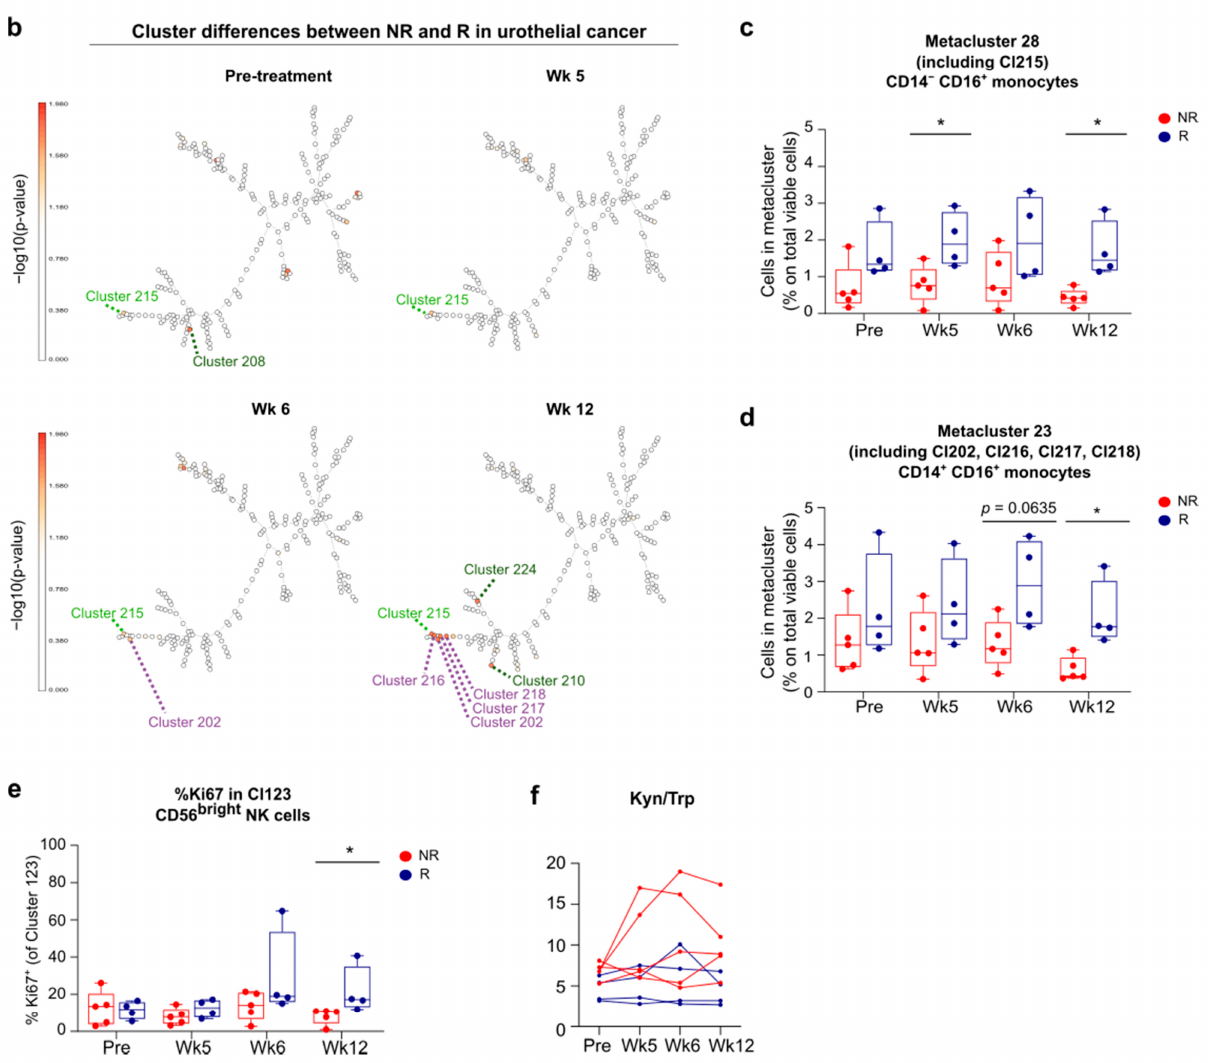
Figure 6. Increased frequency of monocytes associates to response in urothelial cancer. ( a ) FlowSOM tree of concatenated flow cytometry data of PBMCs from 9 UC patients (arm B, 36 samples). ( b ) UC FlowSOM trees depicting differences in the percentage of cells assigned to clusters between non-responders and responders at pre-treatment, week 5, week 6 and week 12 of anti-PD-1 treatment. − log10( p values) are plotted on trees showing the significantly over- or underrepresented clusters in non-responders versus responders. Colors of cluster numbers correspond with immune cell populations in a. ( c ) Boxplots with percentages of metacluster 28 corresponding to CD14 − CD16 + monocytes in non-responders (NR) and responders (R) at indicated times. ( d ) Boxplots with percentages of metacluster 23 corresponding to CD14 + CD16 + monocytes in non-responders (NR) and responders (R) at indicated times. ( e ) Boxplots with percentages of Ki67 expression in cluster 123 corresponding to CD56 bright NK cells in non-responders (NR) and responders (R) at indicated times. ( f ) Lineplots with the ratio of concentrations of serum Kyn and Trp ( × 100) in non-responders (NR) and responders (R) at indicated times. ( c – e ) Whiskers of boxplots extend to the minimum and maximum data point, with the horizontal line indicating the median. p value calculated using two-sided Mann-Whitney U test. * 0.01 < p <